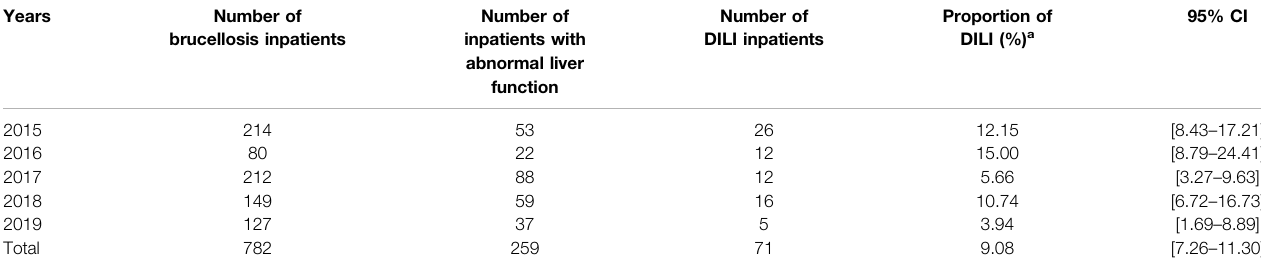
TABLE 1 | Evaluation of the proportion of DILI cases among brucellosis inpatients in Shawan County of Xinjiang province from January 2015 to December 2019. Years Number of Number of brucellosis inpatients inpatients with abnormal liver function